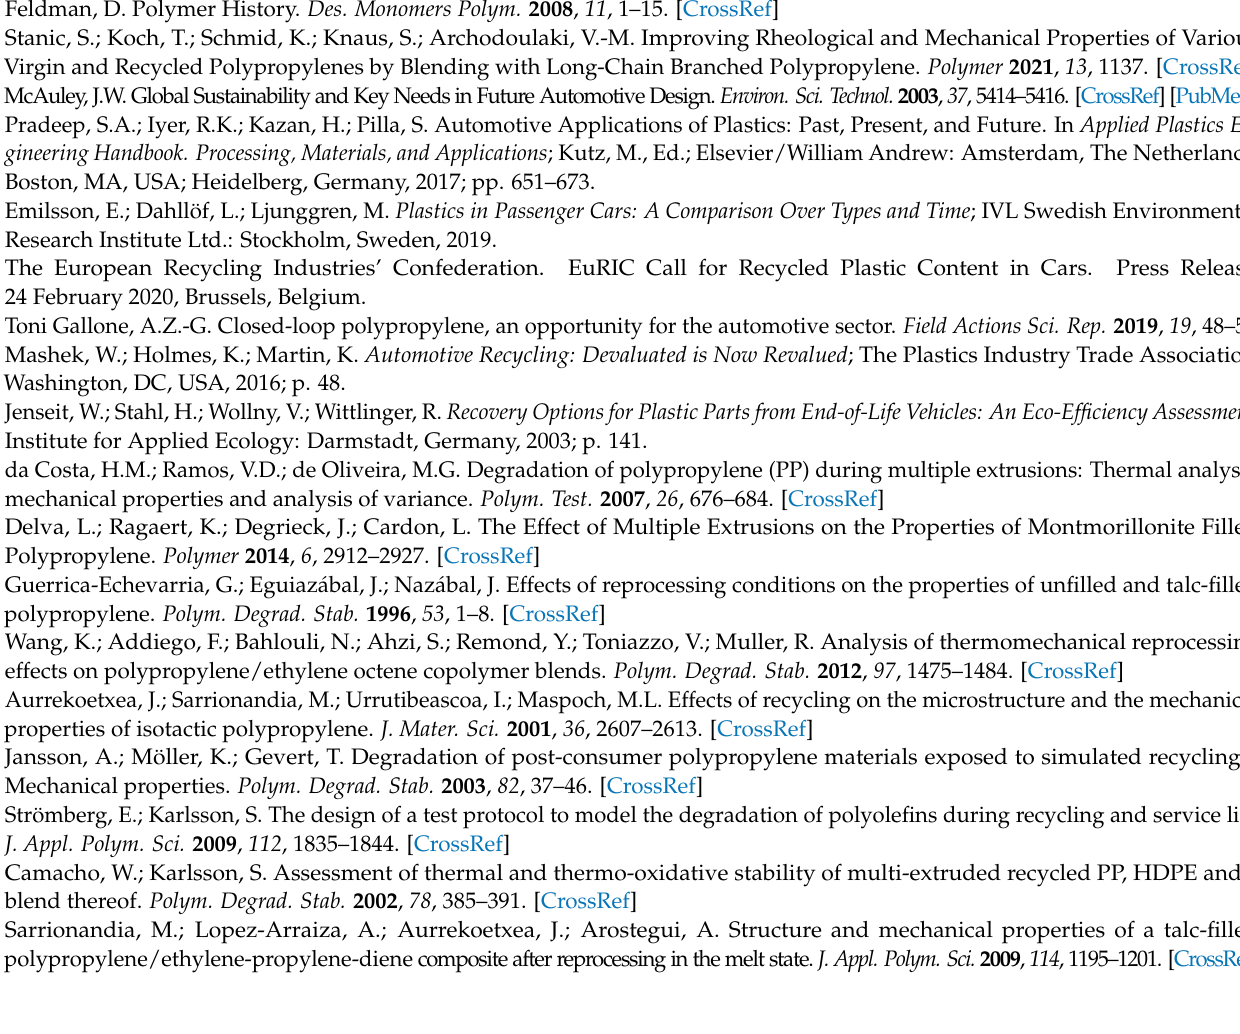
Table S2: Data collected from product data sheets, R: recycled PP, V: virgin PP; PP types and compositions unknown, File S1: References for polymer